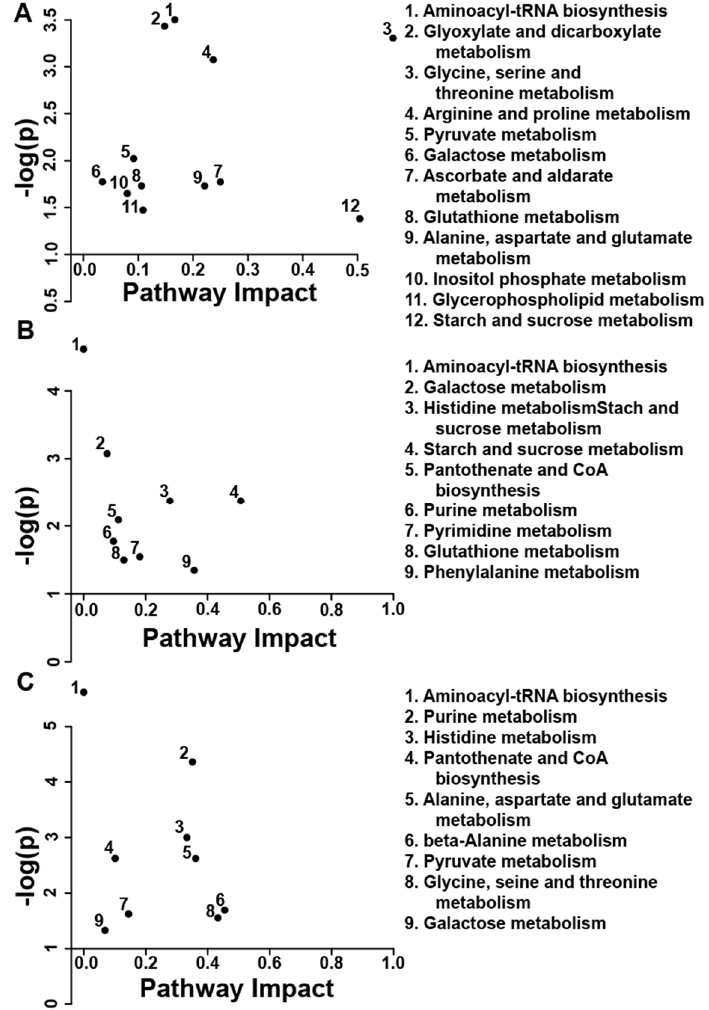
Figure 5. Metabolomic pathway topology analysis showing all matched pathways according to p -values from pathway enrichment analysis and pathway impact values for corticosterone adminis- tered at a dose of 30 mg L − 1 vs. the ethanol control treatment. ( A ) Kidney. ( B ) Liver. ( C ) Breast. A larger value on the y -axis indicates a lower p -value. The x -axis gives the pathway impact as calculated using the hypergeometric test. All metabolic pathways with p < 0.050 are shown. This figure was created using the lists of metabolites identified as significant by paired t -test or multivariate variable importance analysis based on random variable combination testing.